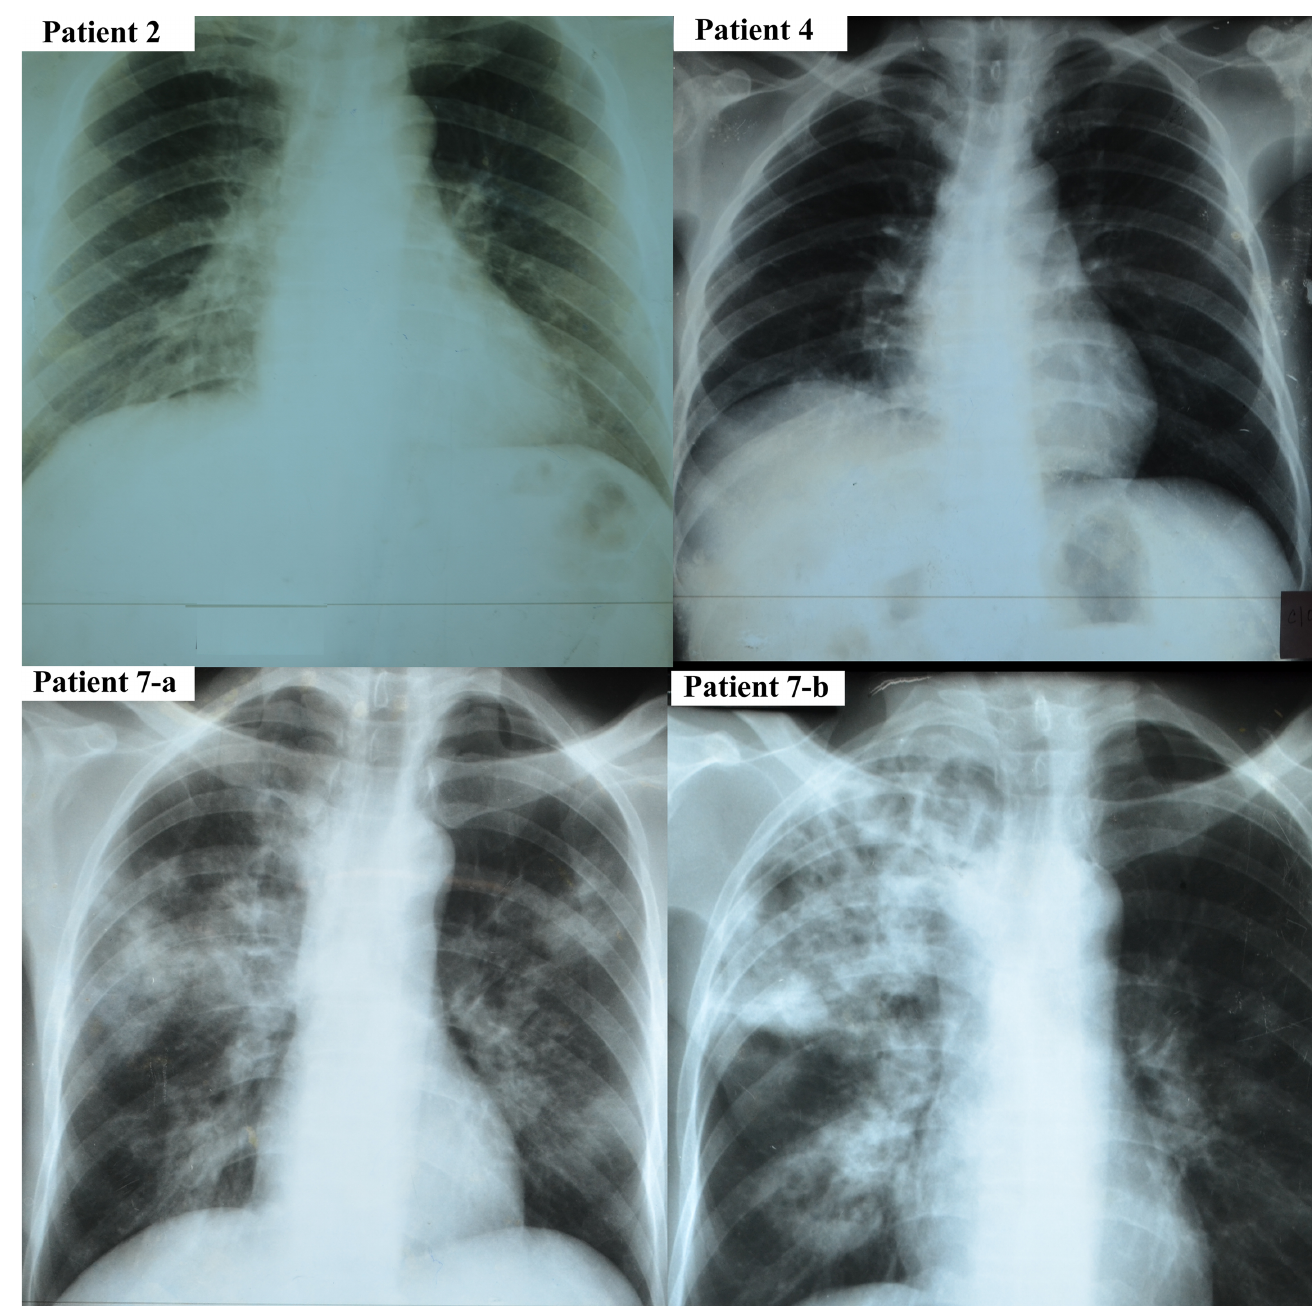
Fig 2. Chest radiography. Plain films taken on hospitalday 1 (patient 2, 4, 7a) and hospital day 9 (patient